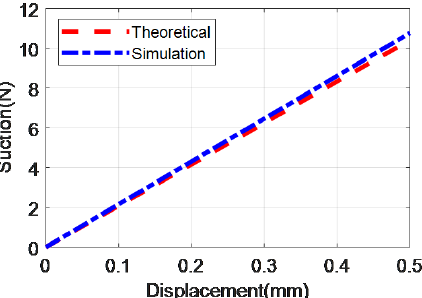
Figure 8. Curves of leaf spring for theoretical and simulation stiff-